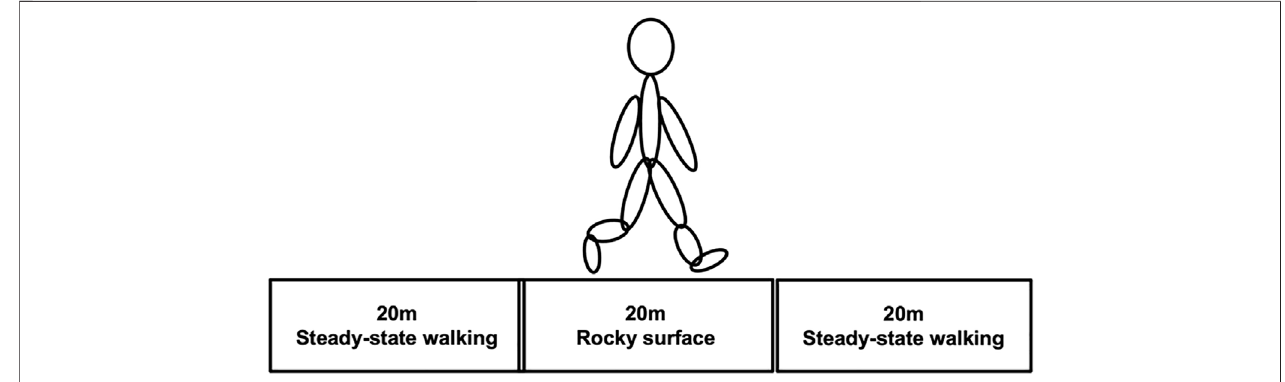
FIGURE 2 | Illustrates the walking